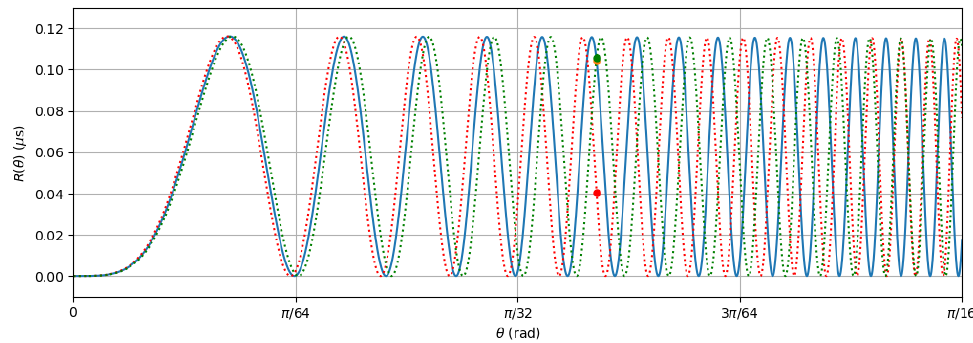
Figure 5. Comparative zoomed plot of the R ( θ ) function relative to the SMBHB candidate PKS 2131–021 and the MSP J2145–0750. The horizontal axis indicates the values assumed by the θ variable, expressed in radians. The vertical axis indicates the values assumed by the R ( θ ) function, expressed in nanoseconds. The green and red dotted lines indicate the values assumed by the R ( θ ) function for χ = 5274 − 186 and χ = 5274 + 58, respectively. The orange dot indicates the value assumed by R ( θ ) when θ coincides with the actual angle between the SMBHB candidate PKS 2131–021 and the MSP J2145–0750, which is θ = 0.1156. The green and red dots indicate the values assumed by R ( θ ) when θ coincides with the actual angle between the SMBHB candidate PKS 2131–021 and the MSP J2145–0750, which is θ = 0.1156, for χ = 5274 − 186 and χ = 5274 + 58,